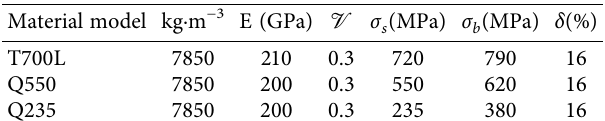
Table 2: Material parameters.